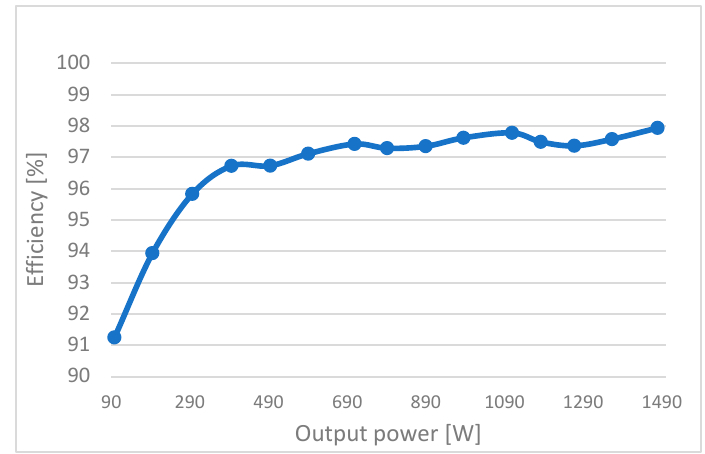
Figure 27. Efficiency plot vs. output power.